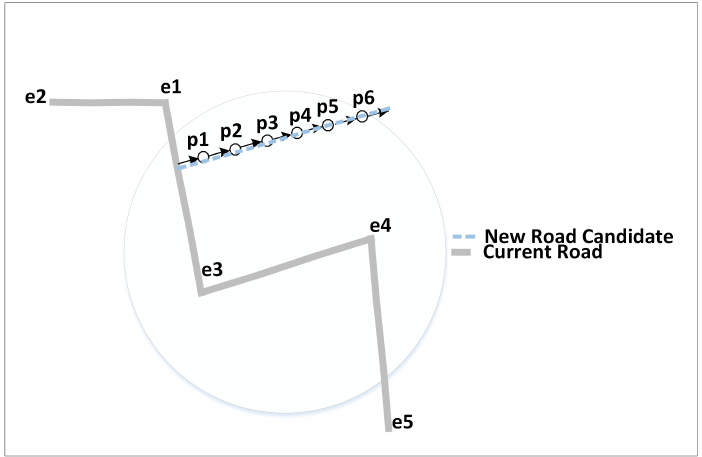
Figure 5. Indicating the newly added roads, point-to-segment